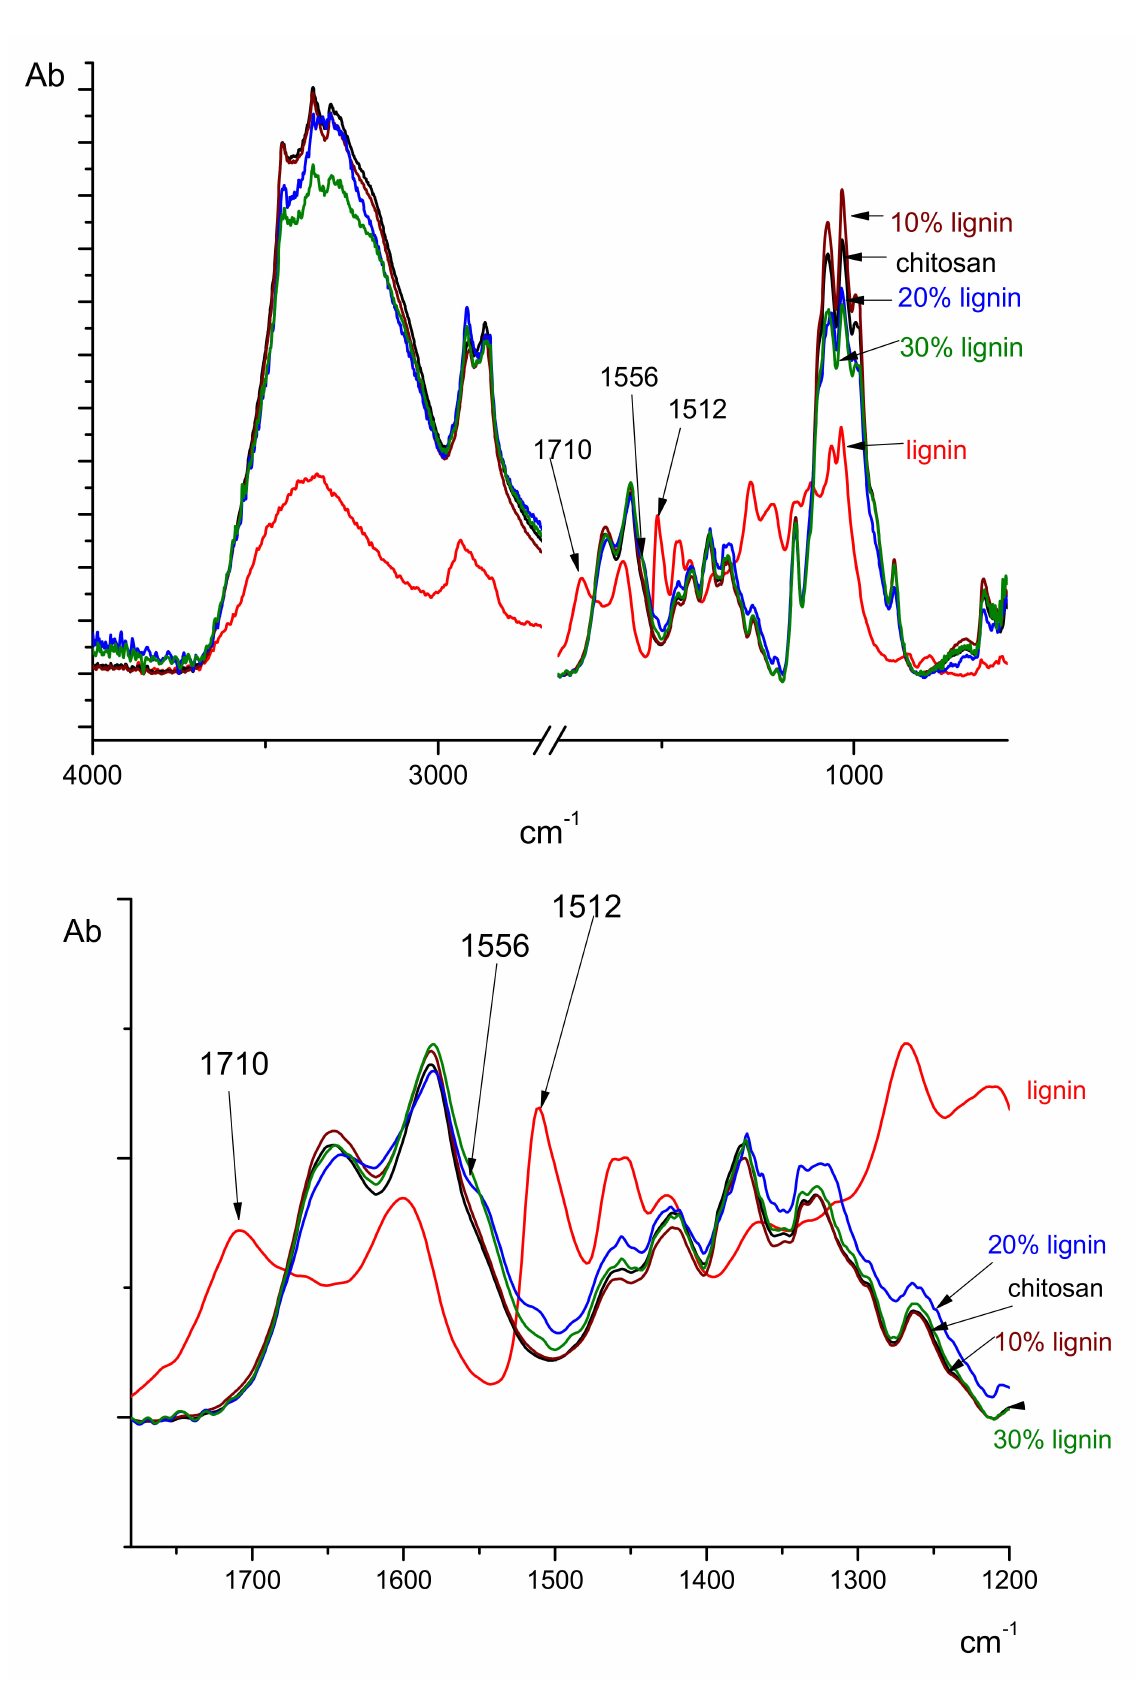
Figure 2. The IR spectra of lignin, chitosan film, and composite films containing 10%, 20%, and 30% of